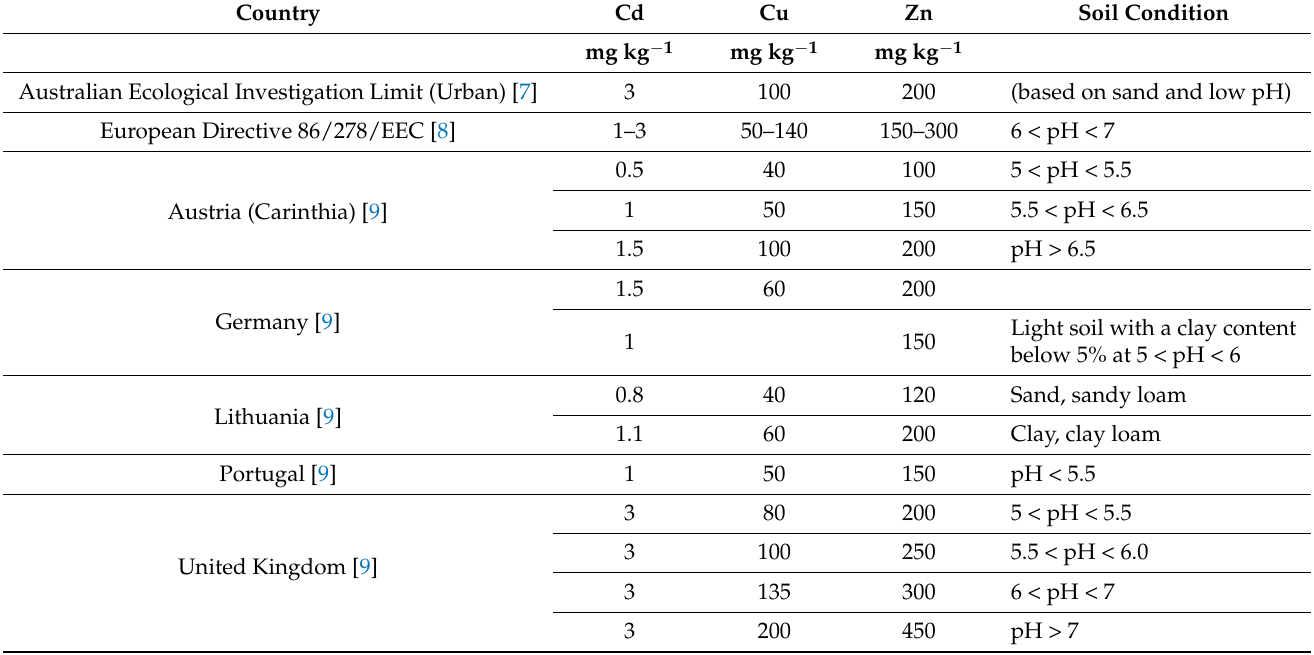
Table 1. Critical limits for heavy metal in soils in some